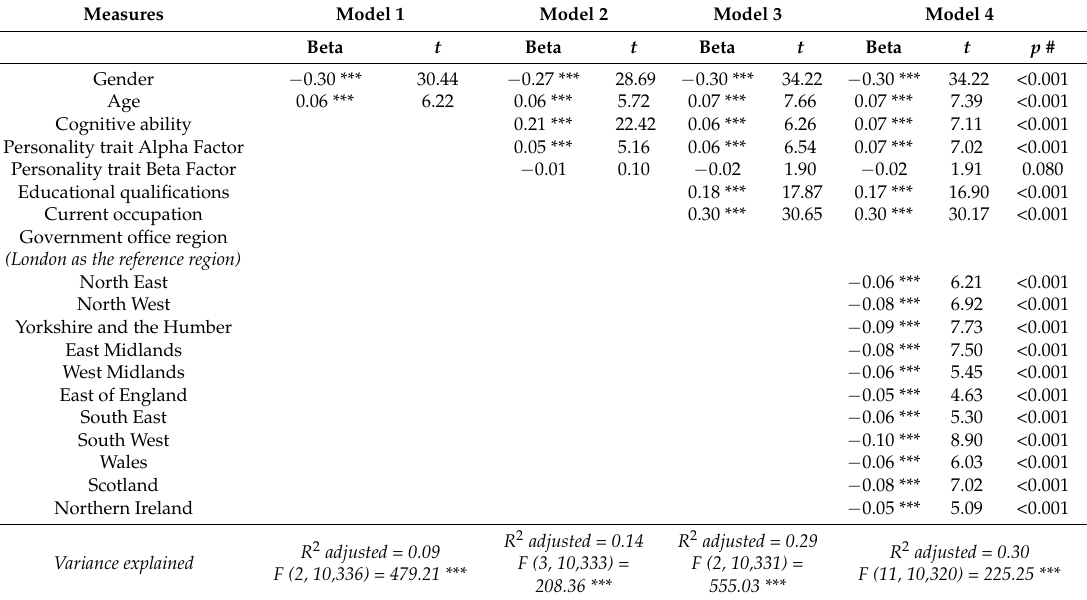
Table 2. Predicting adult income from gender and age, cognitive ability, personality factors, education and occupation, as well as